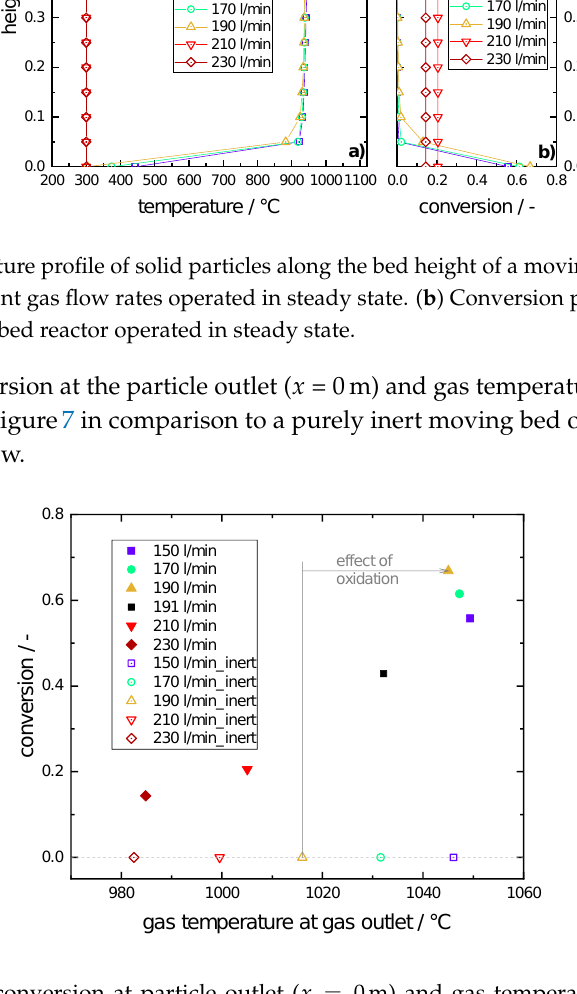
Figure 7. Obtained conversion at particle outlet ( x = 0m) and gas temperature at particle inlet ( x = 0.7m) of a moving bed (4g/s particle flow rate) with different gas flow rates. Full symbols represent thermochemical storage material undergoing a chemical reaction; empty symbols represent inert storage material used for sensible storage